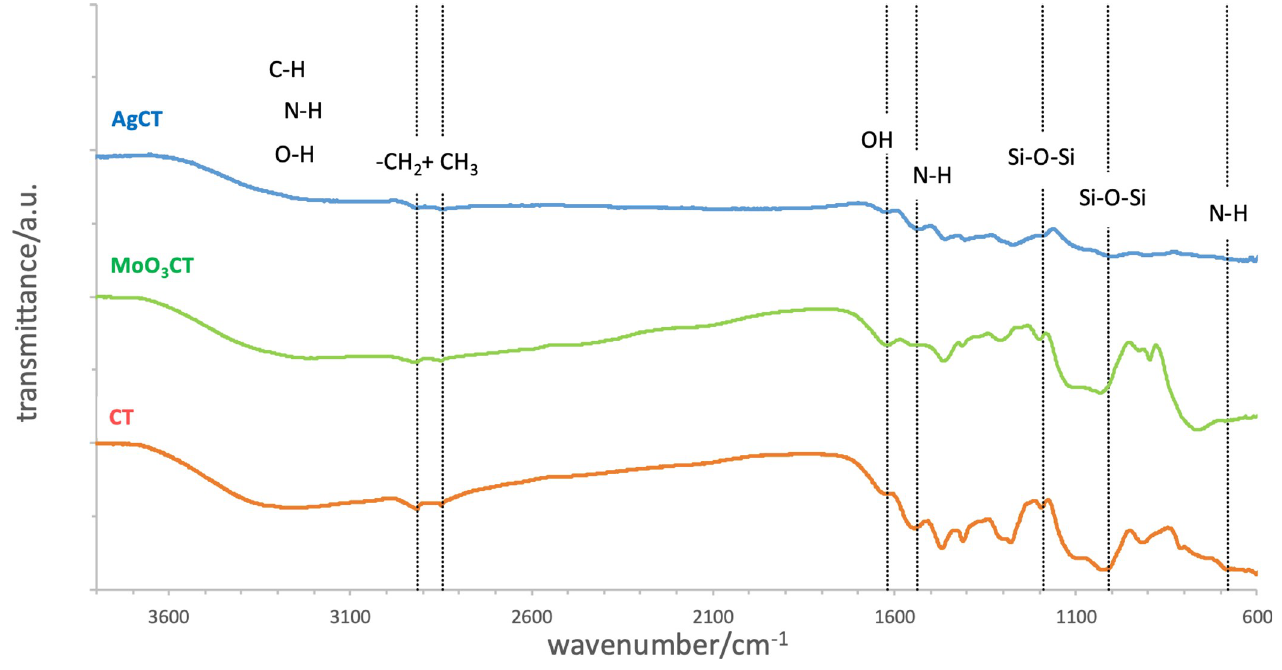
Fig 3. FT-IR spectra of the three coatings (CT, MoO 3 CT, and AgCT).